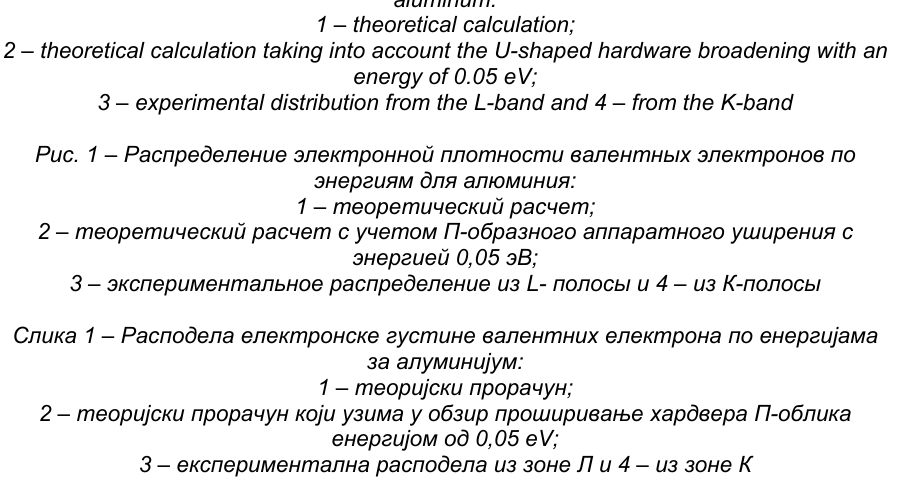
Figure 1 – Distribution of the electron density of valence electrons by energies